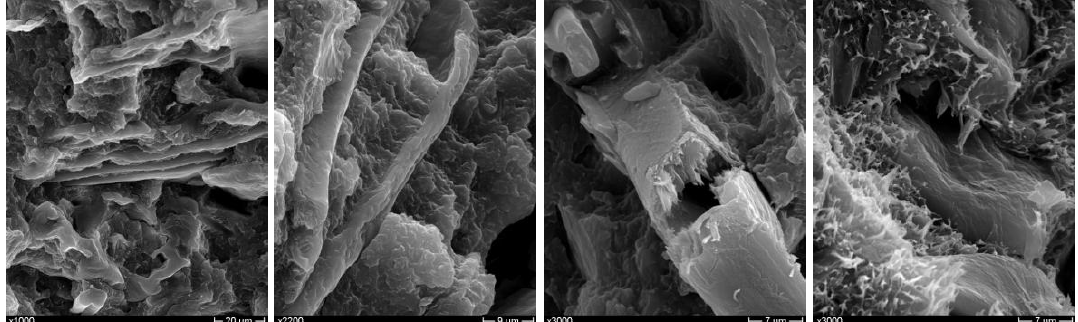
Figure 8. SEM micrographs of biocomposites with 30 wt % CSS after extraction and surface modification with silane at different magnifications.